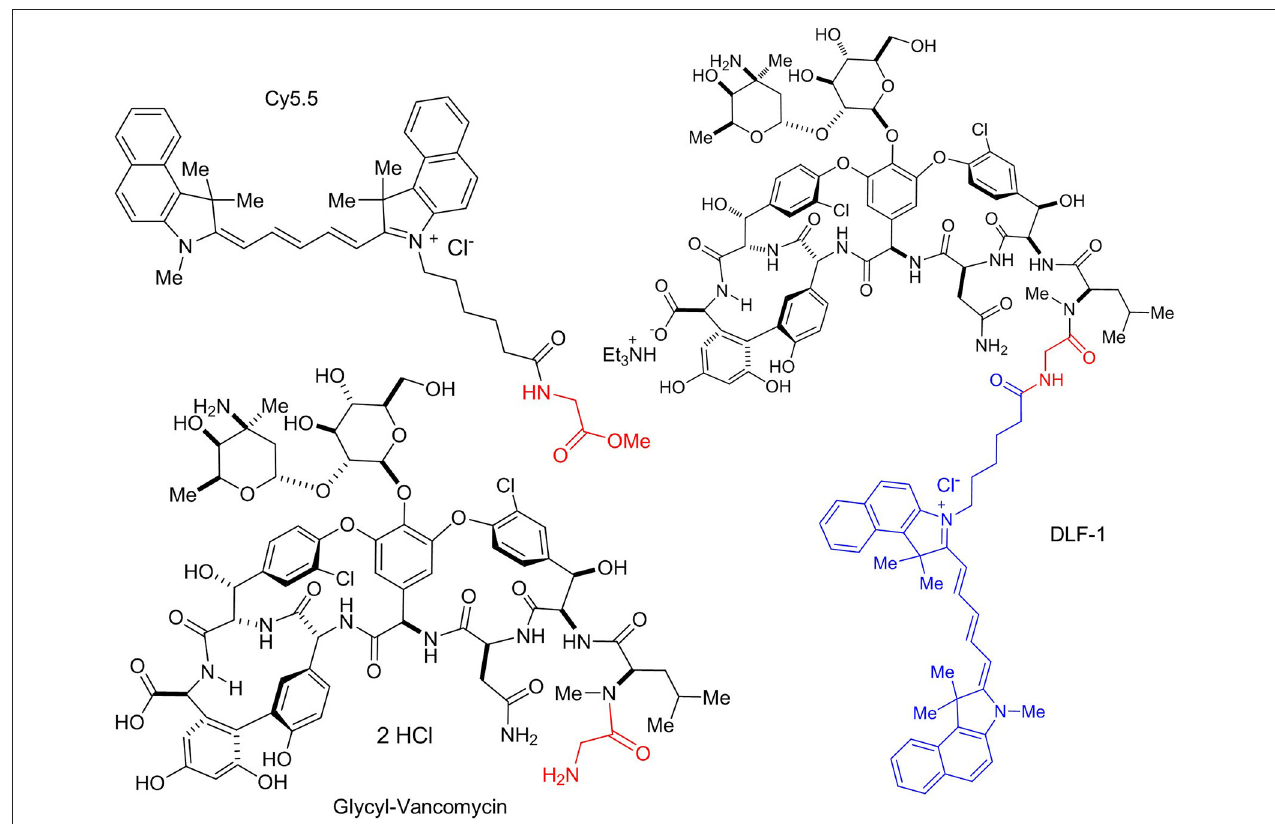
FIGURE 1 | Structure of DLF-1. DLF-1 is synthesized by conjugating glycyl-vancomycin with a near infrared dye